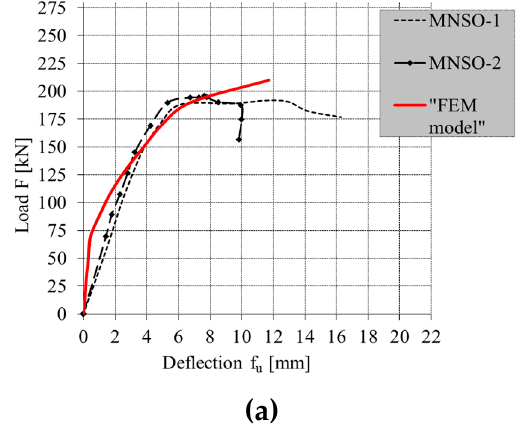
presents the relationship between the load and the displacement of the numerical models and the tests models of confined walls.